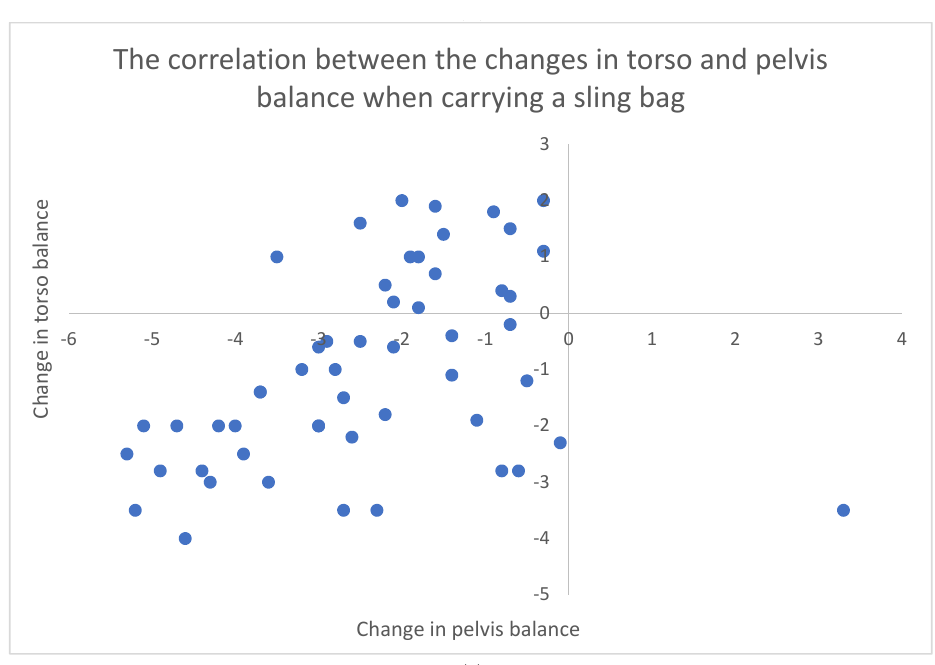
Figure 8. ( a ) The correlation between torso and pelvis when carrying a backpack (R = 0.82); ( b ) the correlation between torso and pelvis when carrying a tote bag (R = 0.49); and ( c ) the correlation between torso and pelvis when carrying a sling/crossbody bag (R = 0.94).